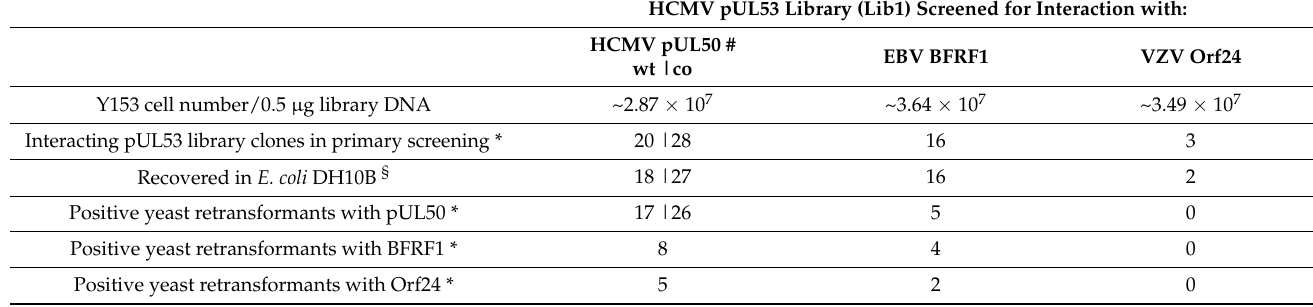
Table 1. Screening procedure to identify pUL53 clones from Lib1 that exert shared-hook binding activity in the Y2H system.